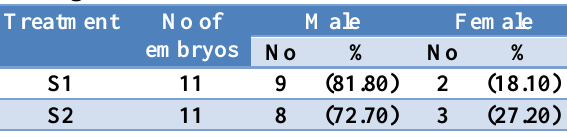
insemination with sex-sorted and